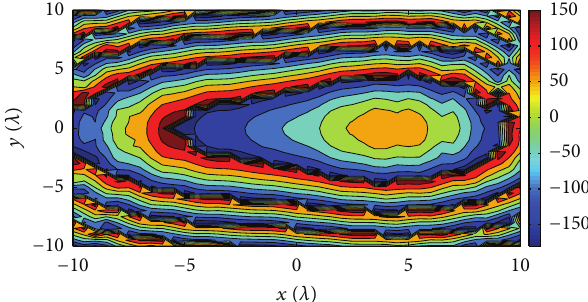
Figure 8: Measured near-field phase on the failure-free slotted waveguide